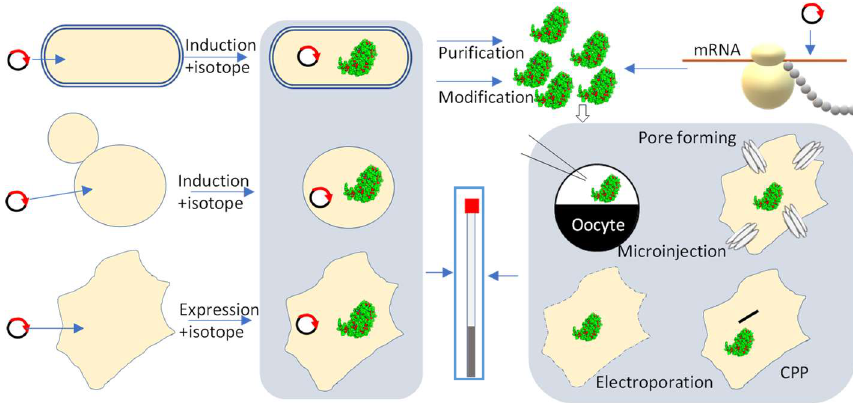
Figure 1. Sample preparation for in-cell NMR studies. The cells used for in-cell NMR studies can be prepared using the following strategies: Proteins (green) can be directly over-expressed in different cell lines using expression vectors. To make isotopically labeled proteins for in-cell NMR studies, the target gene can be cloned into suitable vectors followed with transfection/transformation into cells. Target protein can be isotopically labeled by growing cells in isotopically enriched ( 15 N, 15 N/ 13 C) media. Cells with the overexpressed protein are then used for in-cell NMR experiments. Isotopically labeled proteins can also be prepared in vitro by overexpressing them in different cells or using cell-free expression systems. The labeled protein is then purified before being introduced to oocytes by microinjection. Blue box indicates the NMR tube. Labeled proteins can also be introduced into human cells using either cell- penetrating peptides (CPP), cell permeabilization by pore-forming toxins or electroporation as